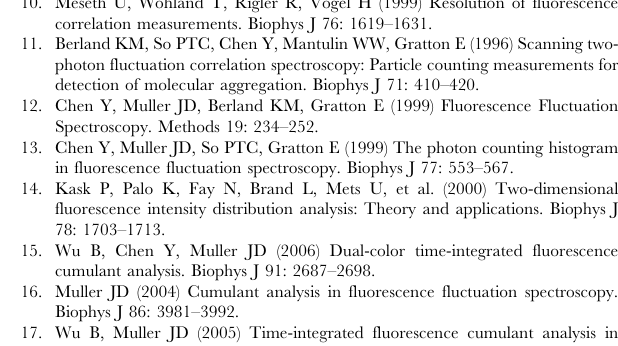
Figure S1 Comparison of t FCS and global- t FCS analy- ses. t FCS analysis (a) allows brightnesses and concentrations to be treated globally across the two data modalities due to common parameters now describing the amplitudes of both the lifetime decay and autocorrelation function. Global- t FCS (b) intrinsically retains the pair-global relationship for each pair individually, in addition to treating the lifetimes, diffusion coefficients, and brightnesses as global parameters across all pairs of the titration. Data has been normalized for visual comparison. Figure S2 Reference data set recorded using uncorre- lated light to assess the systematic error in data acquisitions. A 100 point binomial smoothed data set (black line) removes Poissonian noise while retaining the lower frequencies (red line) used for data corrections. Figure S3 The effects of molecular brightness assump- tions in two component FCS analyses compared to t FCS. Comparison of simulated data sets depicting a binary system with a diffusion coefficient ratio of 3, molecular brightness and lifetime ratios of 2 (a), and titrated across a concentration ratio of three orders of magnitude (b). Here, we have ‘calibrated’ species a and fixed the known values for D a , y a and t a during all subsequent analyses. The covariant autocorrelation amplitudes require that the molecular brightnesses be held for both species using FCS analysis; therefore, we have ‘‘guessed’’ y b in order to attain stable fits. Three different analyses (b) using y b guesses below ( y b = 8 kcpsm; horizontal kites), the same as ( y b = 10 kcpsm; diamonds), and above ( y b = 12.5 kcpsm; horizontal kites) the correct molecular brightness value highlight the potential inaccuracies in two component FCS results. Across concentration ratios C a /C b of 0.03 to 1, in which the amount of unknown species is sufficiently large, FCS analysis can distinguish the 2nd